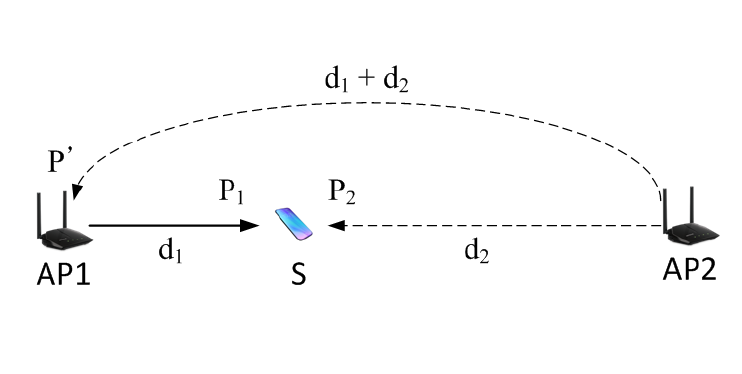
Figure 2. An example network scenario for calculating CST. Distance between the transmitting node and the interfering node is estimated based on a pathloss model, and CST is calculated based on the